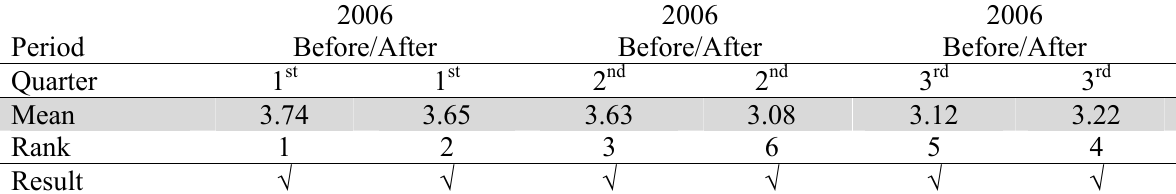
The results of testing the first hypothesis for the years of 2006 2006 2006 2006 Period Before/After Before/After